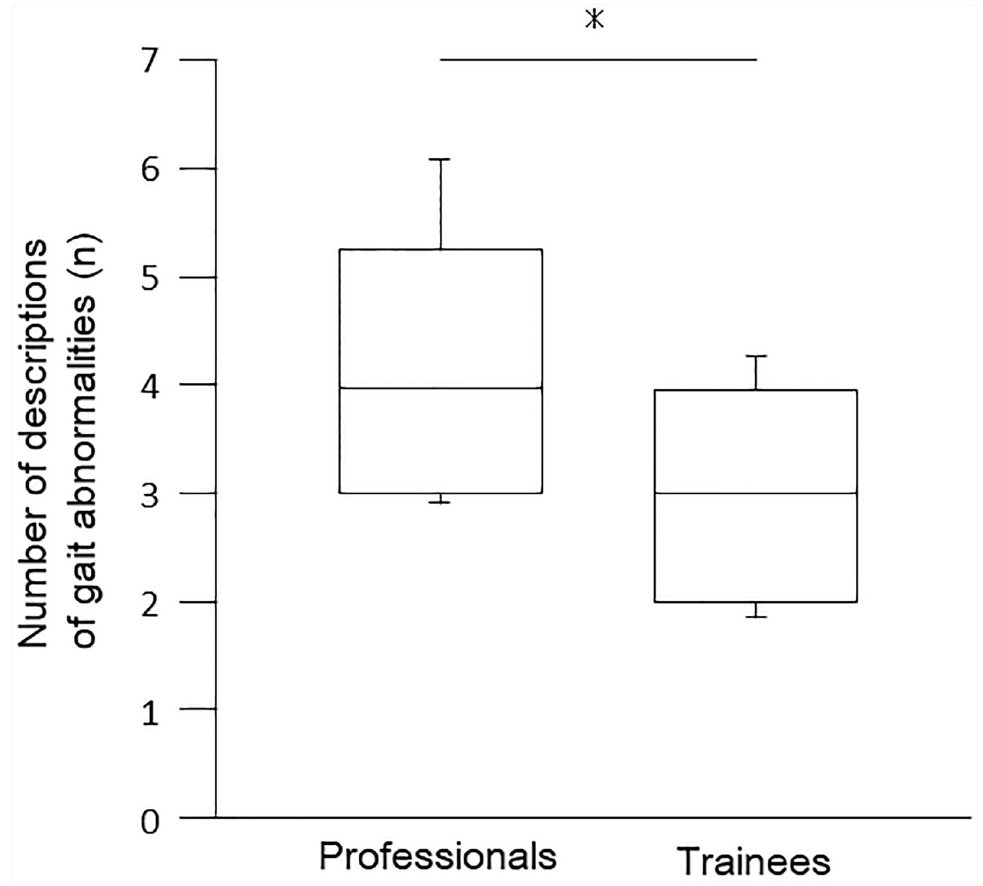
Fig 1. The number of descriptions of gait abnormalities. Values are expressed as medians and interquartile ranges (IQR) with standard deviation error bars. Asterisk shows statistical significance, � : p < .05 professionals vs. trainees.